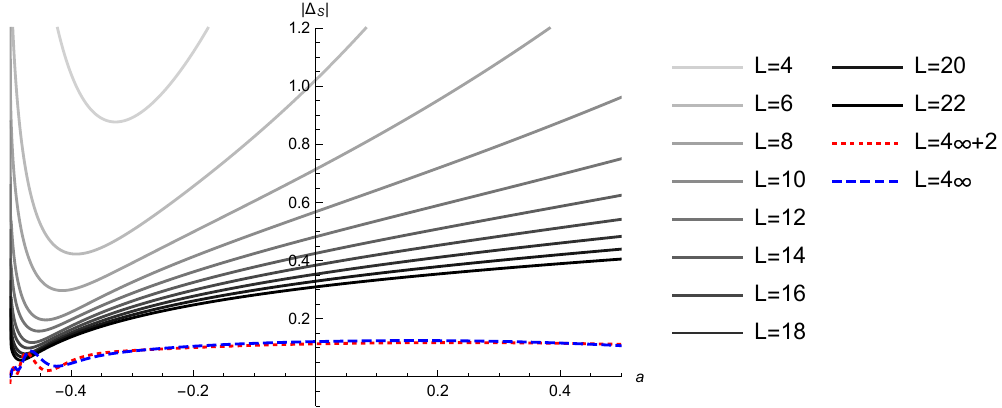
Figure 15 . Plots of | ∆ S | (2.21) for the “ghost brane” solution Φ G horizontal axis denotes the value of the parameter a .